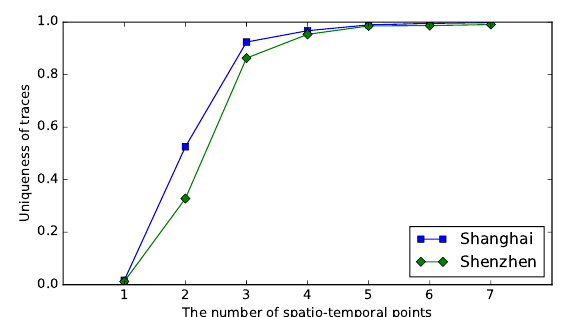
Figure 3. The Uniqueness of Traces with A Specific Number of Known Non-anonymous Spatial-Temporal Points. Given a 100 × 100 spatial resolution and 20 minutes temporal resolution, the uniqueness is up to 95.35% for Shenzhen taxis and 96.75% for Shanghai’s, when the number comes to 4.